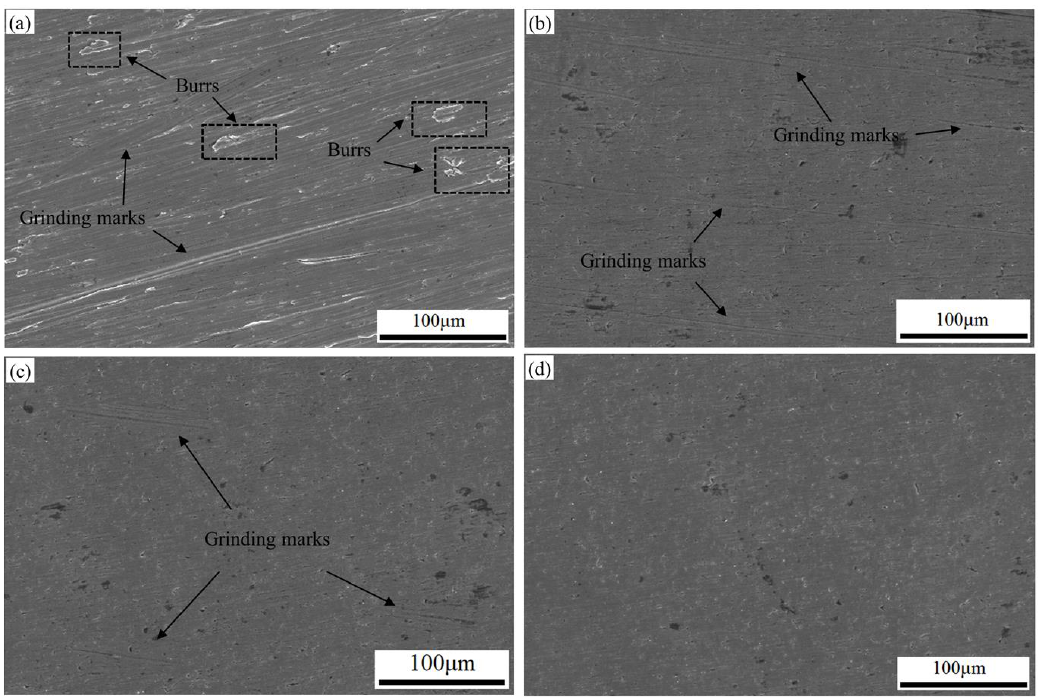
Figure 14. SEM micrographs of ( a ) original surface; ( b ) finished surface when employing 1 mm working gap, 2500 rpm, 1 mm/min and 150 mesh in MAF; ( c ) finished surface when employing 2 mm working gap, 1638 rpm, 1 mm/min and 150 mesh in MAF; ( d ) finished surface when employing 1 mm working gap, 1638 rpm, 1 mm/min and 150 mesh in MAF.